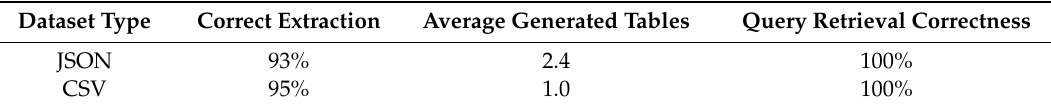
Table 3. Correct extraction percentage, average generated tables and query correctness per